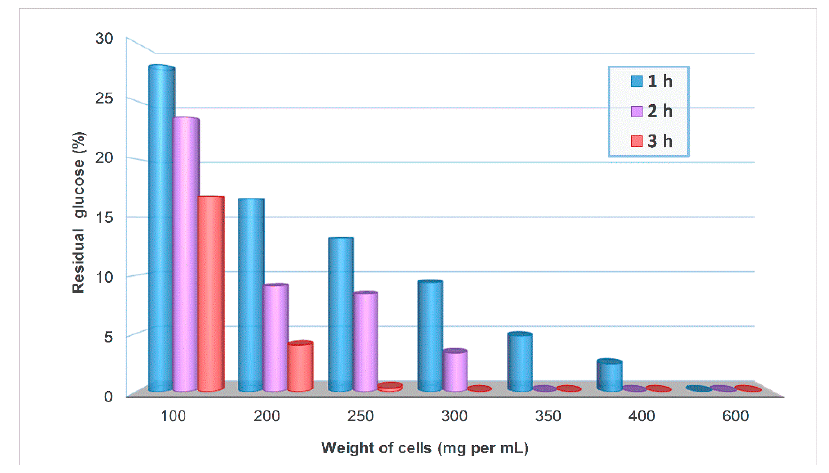
Figure 2. Effect of the amount of cells (wet weight) of Pichia pastoris on the elimination at 30 °C of D- glucose in a solution containing 100 g/L of both D -glucose and D -galactose. 2.4. E ff ect of pH and Temperature on the Stability of L-Arabinose